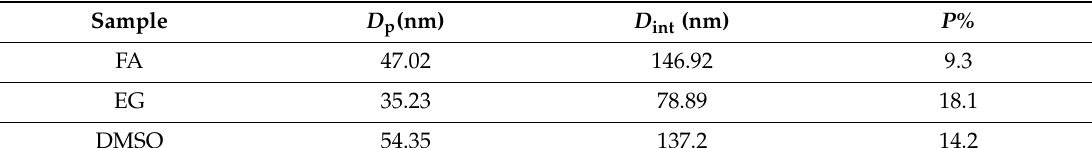
Table 1. AHO nanoporous and nanotubes geometrical parameters: pore diameter ( D p ) interpore distance ( D int ) and Porosity ( P ) for the di ff erent samples.